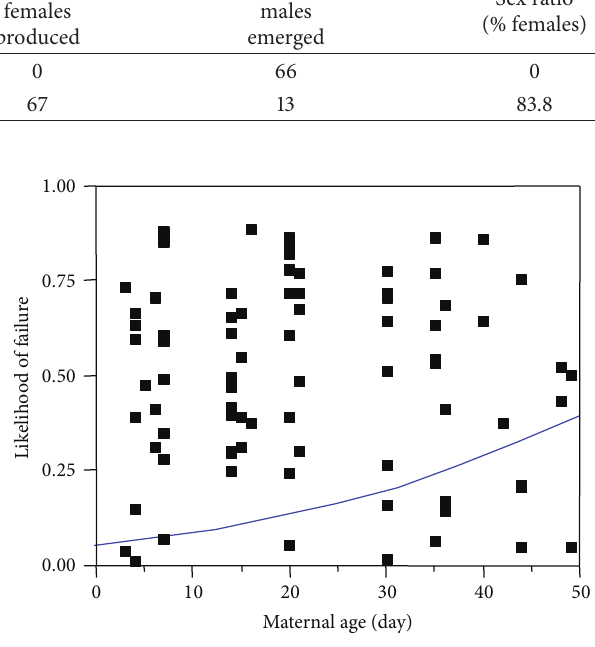
Figure 1: A logistic regression line obtained for the relationship between maternal age and likelihood of fertilization failure. The pointsareplacedmidwaytoassuretheirvisibility,andthehorizontal placement of each point (= one oviposition event) is made with respect to the horizontal axis (= female wasp age). The points above or below the curve show data set in which test females produced female or male offspring (see JMP User’s